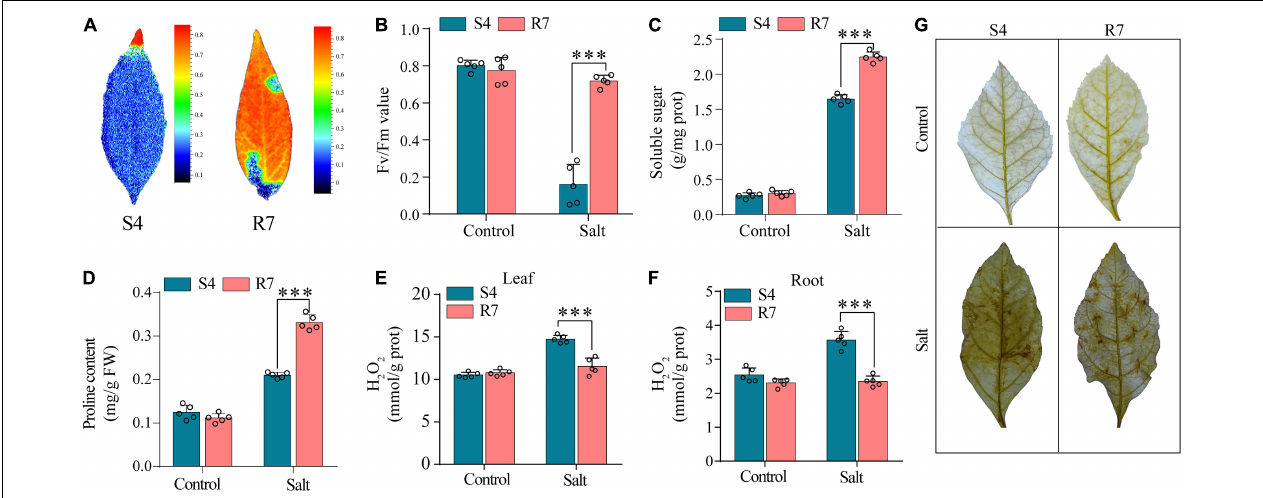
FIGURE 1 | Determination of selected biochemical parameters in F. velutina R7 and S4. (A) The images reflecting chlorophyll fluorescence parameters. (B) Chlorophyll fluorescence parameters ( Fv / Fm ratio) of the excised leaves of F. velutina R7 and S4 exposed to 250 mM NaCl for 48 h. Soluble sugar (C,D) proline content in R7 and S4 roots with or without salt treatment. (E,F) H 2 O 2 content in leaves (E) and roots (F) of R7 and S4 before and after salt stress. (G) In situ visualization of H 2 O 2 accumulation by DAB staining in R7 and S4 leaves before and after salt stress. Error bars represented SD ( n = 5). ∗∗∗ P < 0.001 represented significant